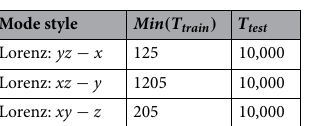
Table 1. Shortest training length of the Lorenz system in the case 1( T test = 10 4 , RMSE < 0.1